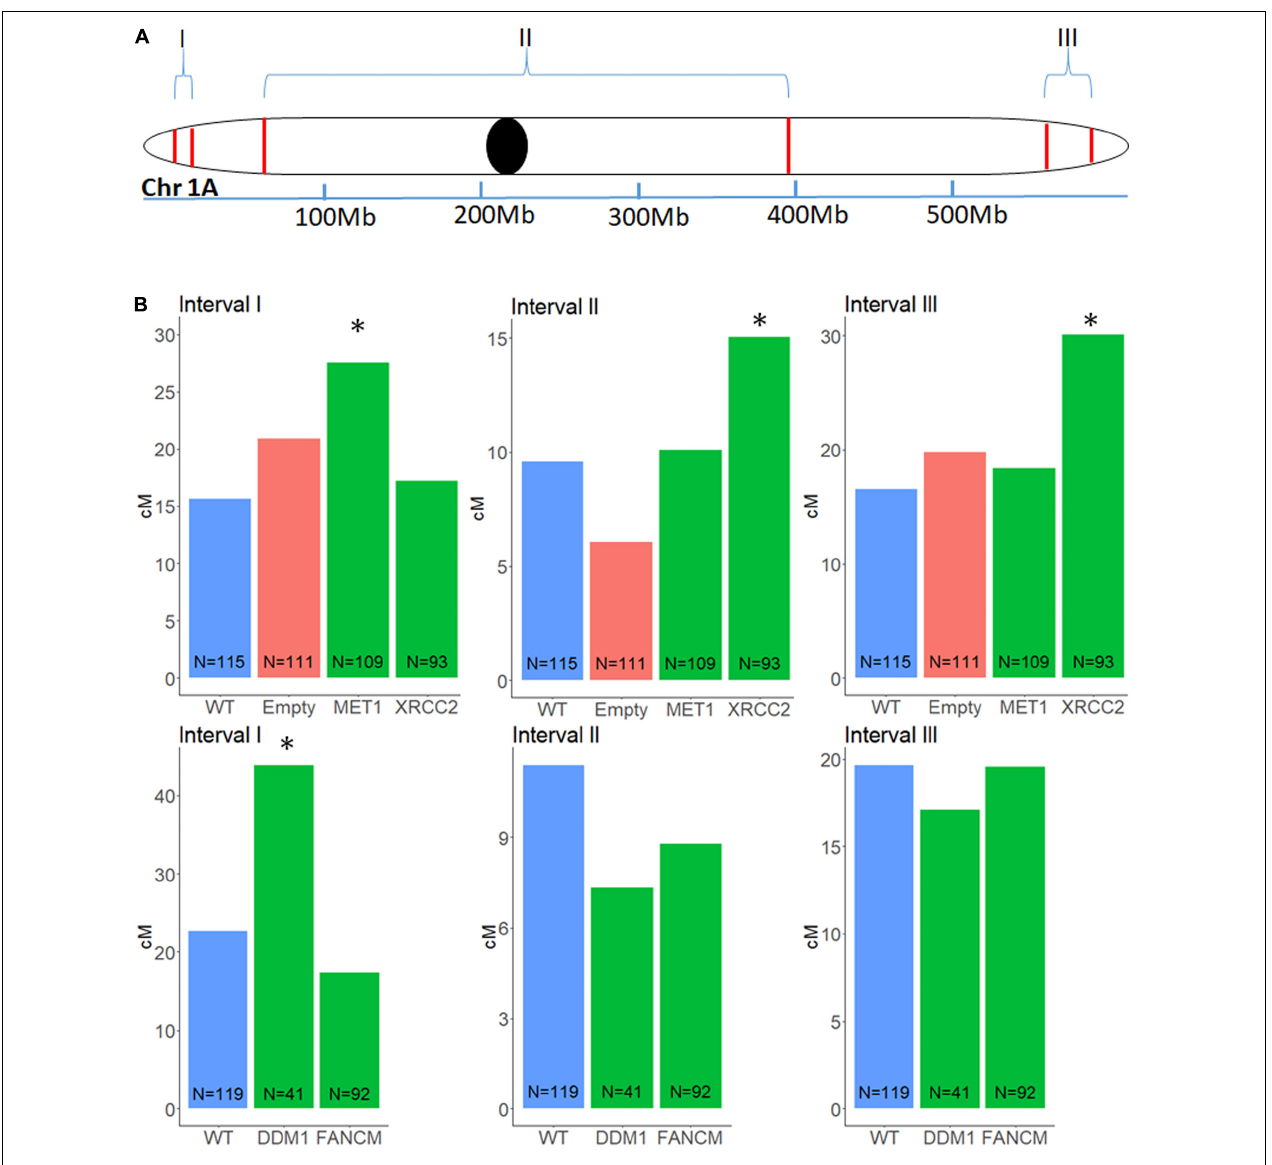
FIGURE 3 | Genetic distance in a F2 (Zavitan x Svevo) population, between three pairs of markers on chromosome 1A, after VIGS treatment of F1 plants. Markers were selected from a list of InDels between Zavitan and Svevo chromosomes. (A) Schematic map of the three intervals measured for changes in genetic distance. I, left arm sub-telomeric region; II, peri-centric region; III, right arm sub-telomeric region. (B) Effect of VIGS for MET1 , XRCC2 , DDM1, FANCM and their untreated WT F2 plants and empty vector control. locations of transition between genotypes correspond to a CO event. The number of plants in each population N, is marked at the base of the column. Asterisk designate significant difference from WT ( p <